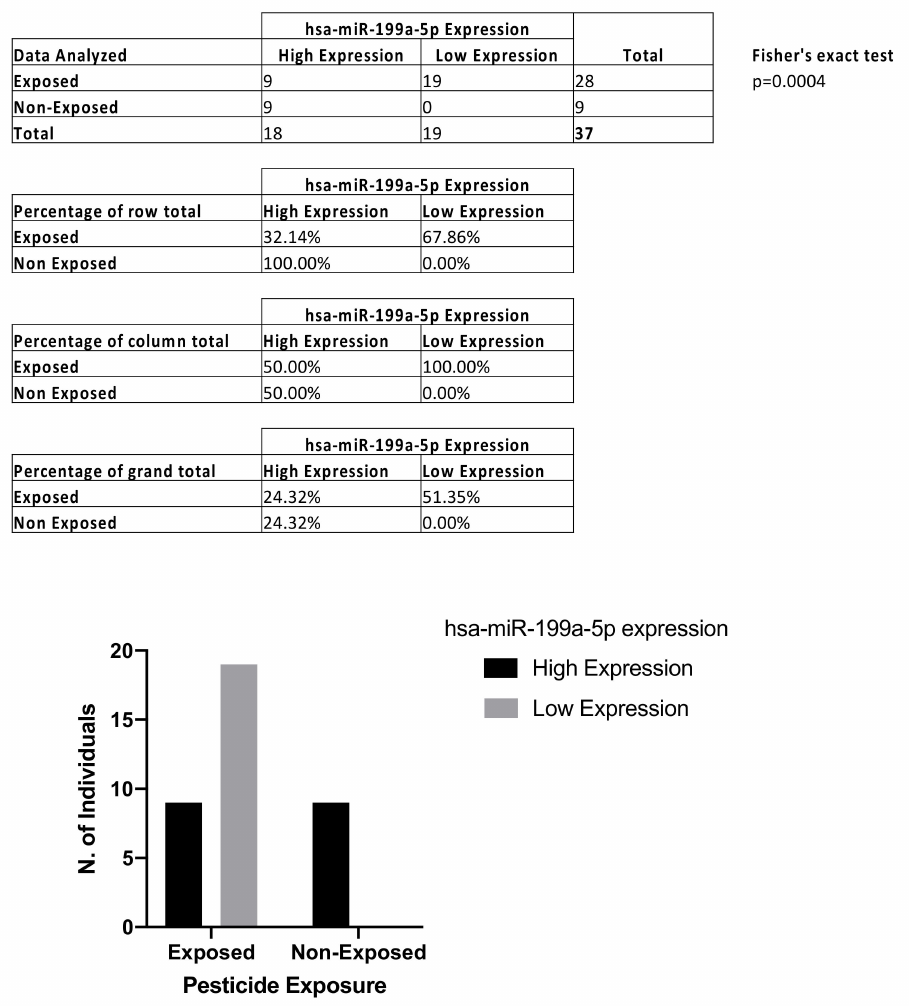
Figure 2. Contingency table and Fisher’s exact test to establish the association between hsa-miR-199a- 5p and pesticide